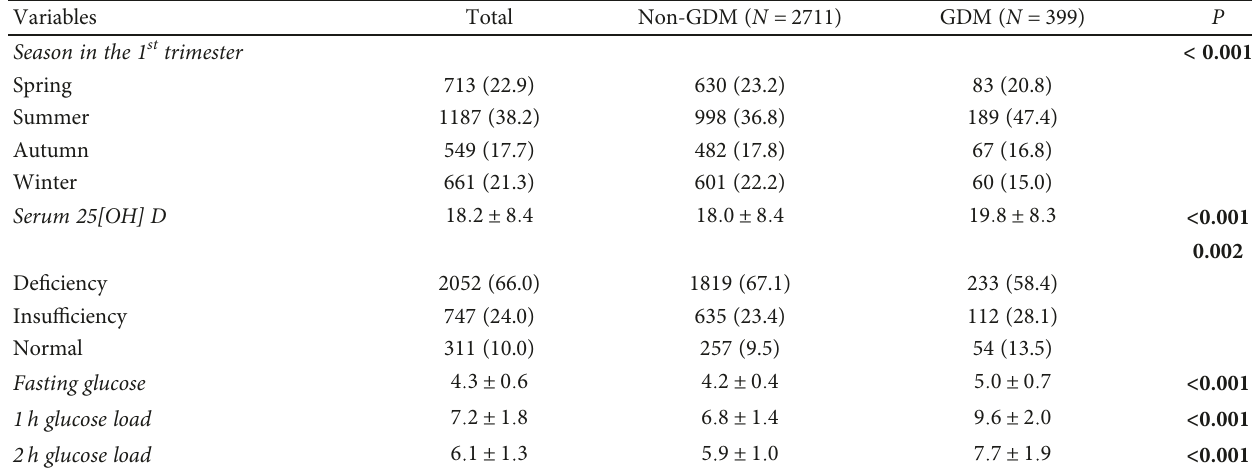
Table 2: The association between vitamin D concentration in the fi rst trimester, conception season, and risk of GDM. Variable Crude OR (95% CI)